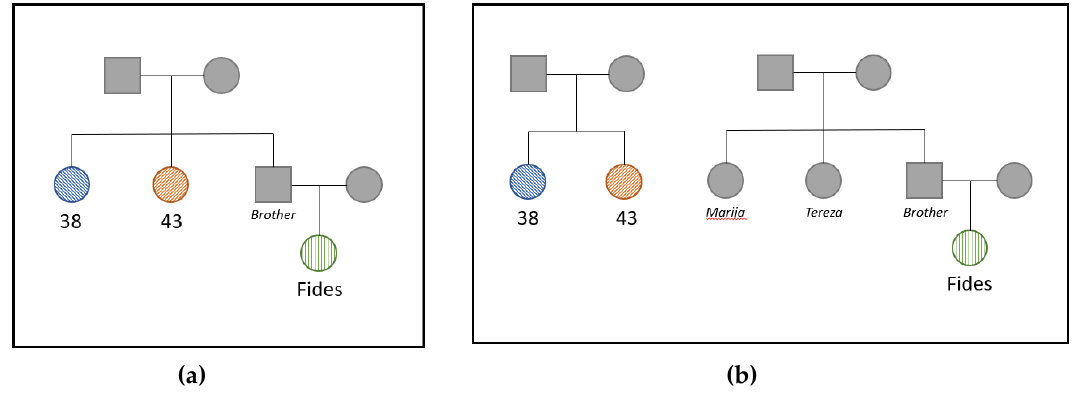
Figure 5. ( a )(left) and ( b ) (right). Hypothetical pedigree scenarios compared. Figure 5. ( a , b ) Hypothetical pedigree scenarios